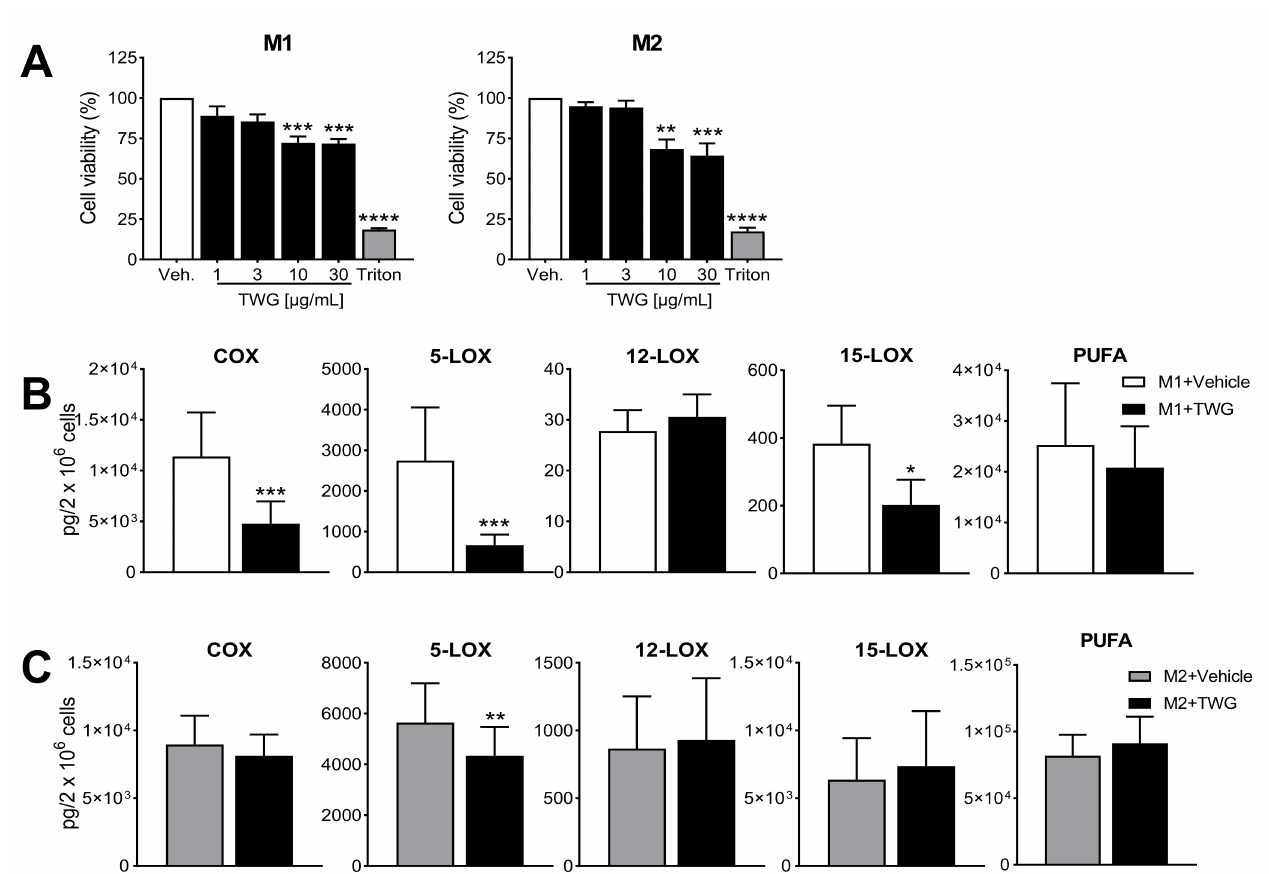
Figure 4. Effects of TWG on cell viability and LM pathway modulation during polarization of human M1- and M2-MDM. Human monocytes were differentiated towards M0 macrophages using GM-CSF or M-CSF for 6 days. These M0 GM-CSF and M0 M-CSF were pretreated for 15 min with test compounds or vehicle and then polarized for 48 h towards M1-MDM using LPS plus IFN γ or towards M2-MDM using IL-4, respectively. ( A ) TWG at the indicated concentrations, 10% triton X-100 or 0.1% DMSO as vehicle were added as test compounds and after 48 h polarization, cell viability was assessed by MTT assay. Data are means + S.E.M., n = 3 (both M1-MDM and M2-MDM), expressed as percentage of vehicle control (=100%); * p < 0.05, ** p < 0.01, *** p < 0.001, **** p < 0.0001, TWG vs. control group, one-way ANOVA for multiple comparisons with